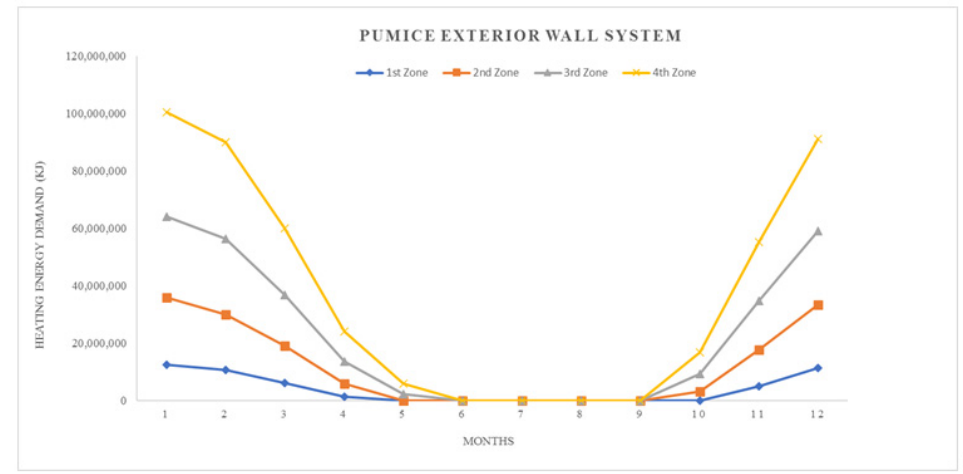
Figure 13 . Heating energy demand for pumice exterior wall system . Figure 13. Heating energy demand for pumice exterior wall